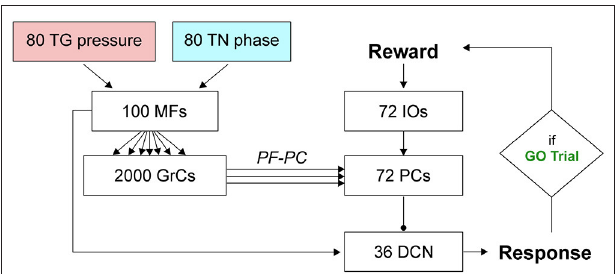
TABLE 2 | Connectivity of the SNN cerebellar